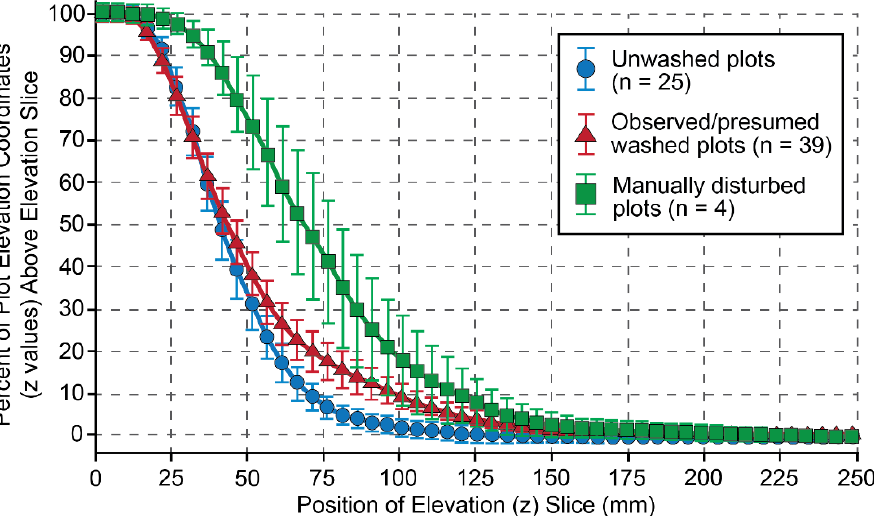
Figure 12. Comparison of the percentage of z-values extending varying distances above the standardized zero elevation for a given DTM for compiled unwashed, O/P washed, and manually disturbed (Validation Test #3) photoplots.